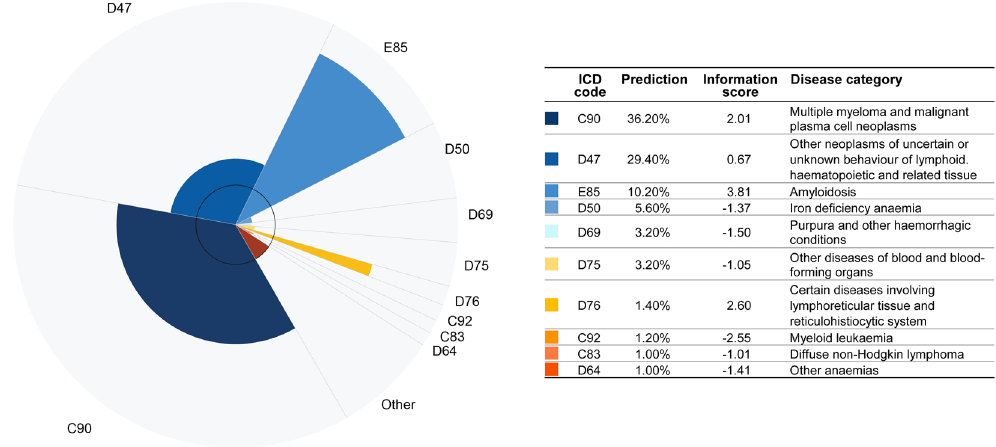
Figure 6. Graphical representation of the predictive model results. The ten most likely diseases are depicted in a polar chart with varying radii. Each chart slice represents a disease whose angle corresponds to the predicted (posttest) disease probability and whose radius is proportional to the logarithm of the ratio between pre- and post-test, the (prevalence) probability or information